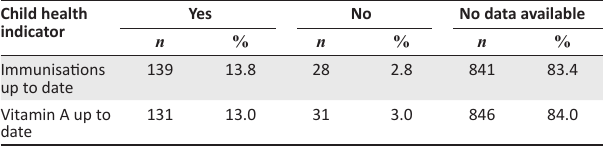
TABLE 1: Immunisation and vitamin A administration (01 January–31 December